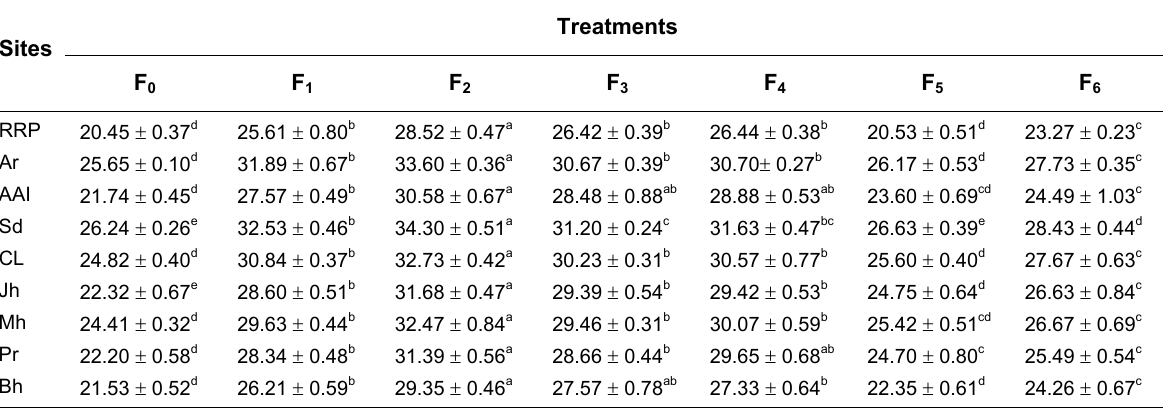
Effect of Different Fertility Levels on Test Weight (g) of Wheat Plants Grown at Various Sites*